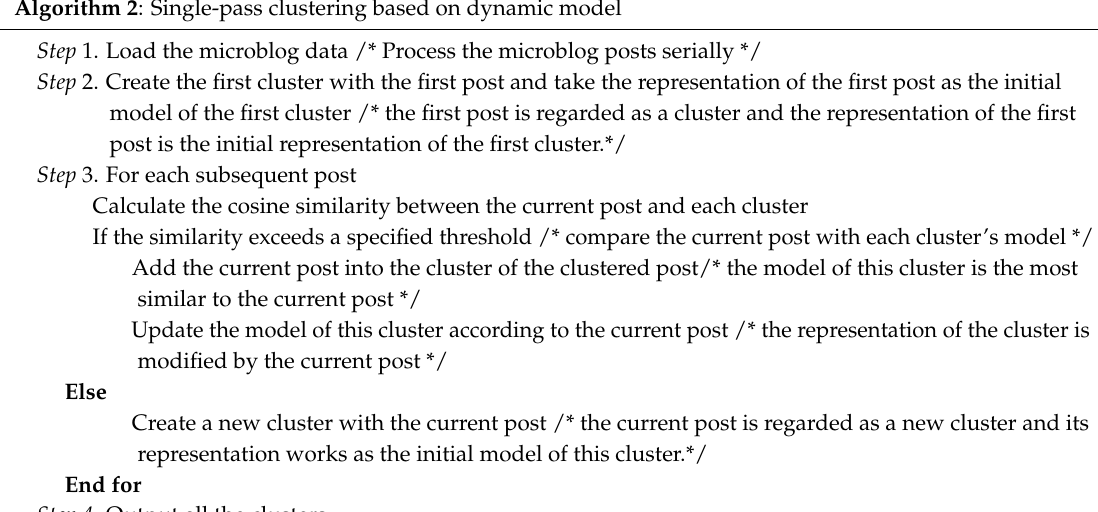
Algorithm 2 : Single-pass clustering based on dynamic